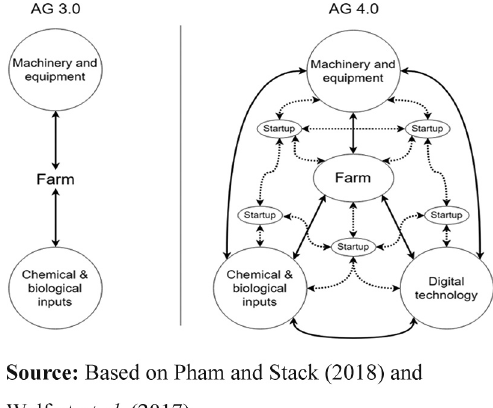
Figure 1. Agricultural inputs landscape during